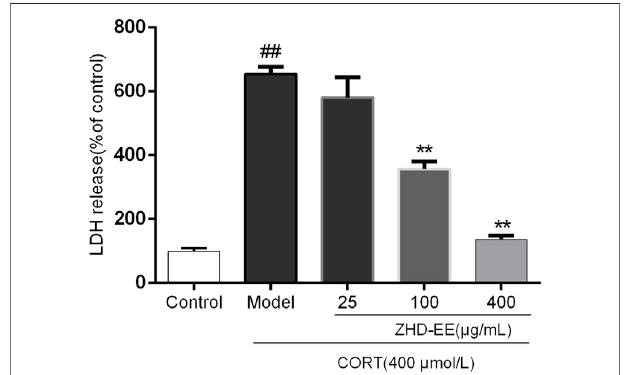
FIGURE 4 | Effects of ZHD-EE (25, 100, and 400 μ g · mL − 1 ) on the LDH leakage inCORT-treated PC12 cells. The valuesgivenare the mean ±SD ( n = 3); ## p < 0.01 compared withthe control group; ** p < 0.01 compared with the model group. ZHD-EE: ethanol extract of